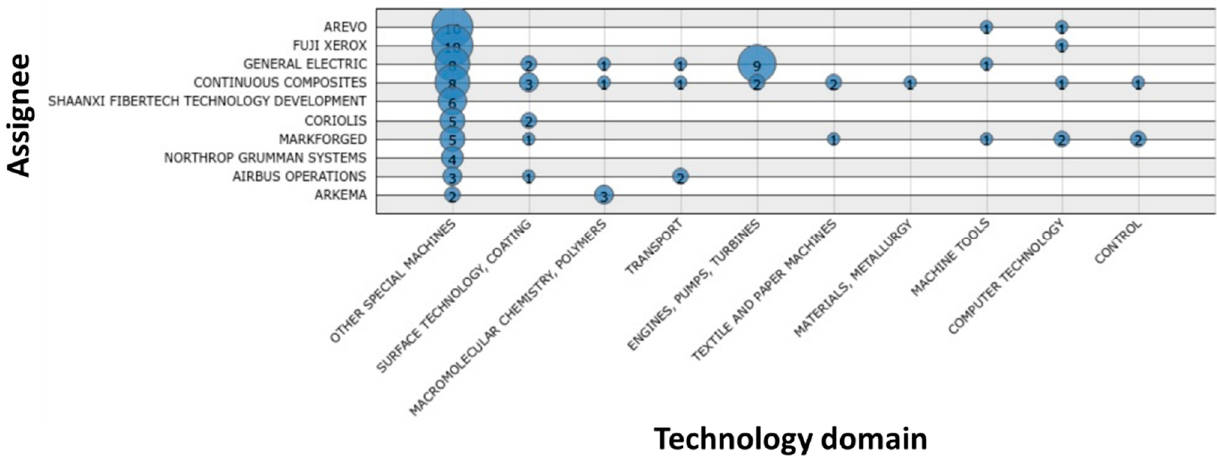
Figure 15. Main technology domains covered by the 10 largest private assignees in FFF adapted to CFRTPC printing in February 2021.